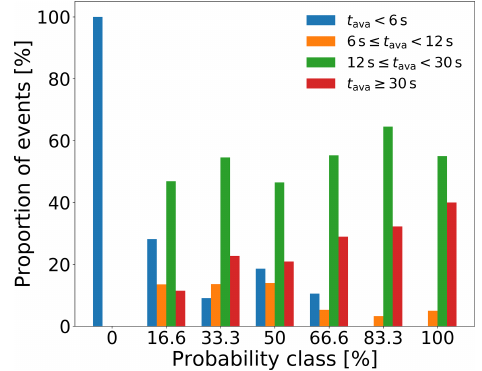
Figure 4. Event duration distribution per probability